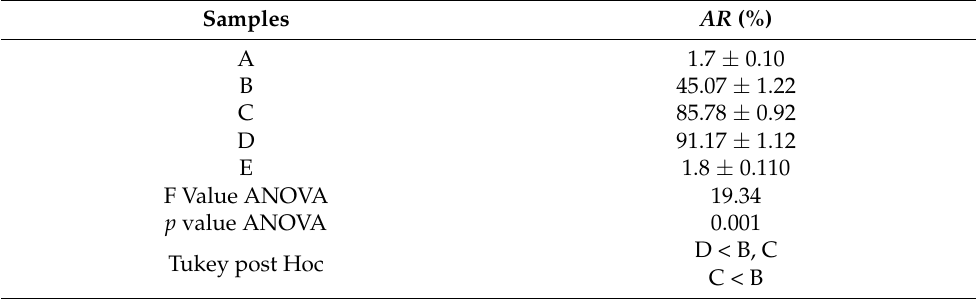
Figure 6. SEM micrographs of the bacteria S. mutans after 24 h of incubation time. The micrographs were made on ( I ) Group A — BIOD; ( II ) Group E — 98.5%BIOD with 1.5% cefuroxime; ( III ) Group